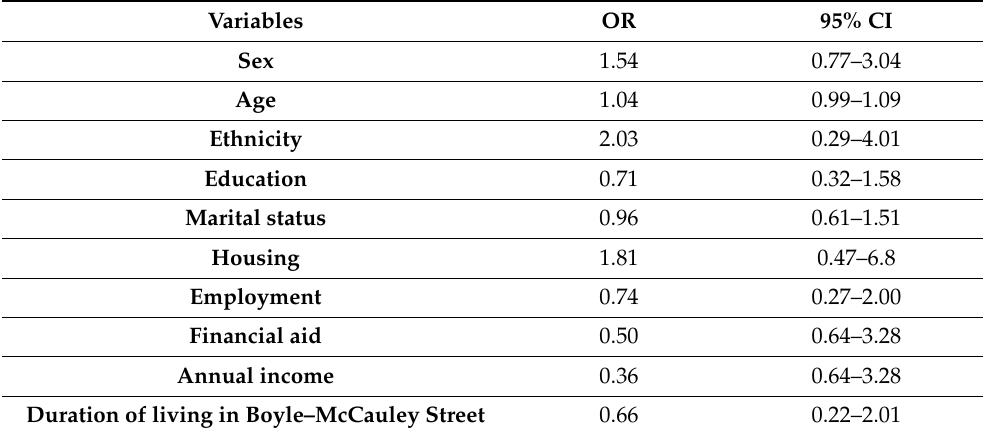
Table 7. Statistical analysis—multiple